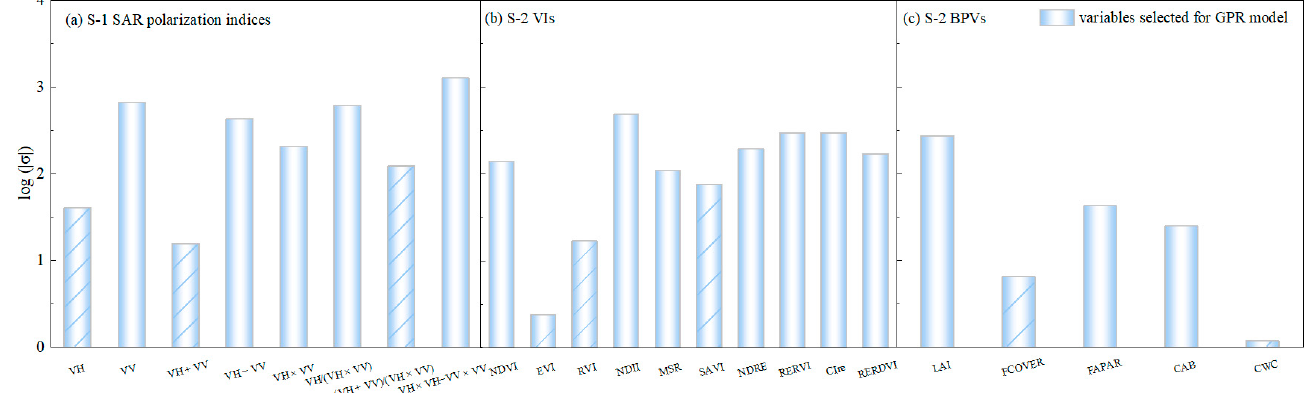
Figure 4. The logarithmic σ of GPR models with different groups of input predictors.